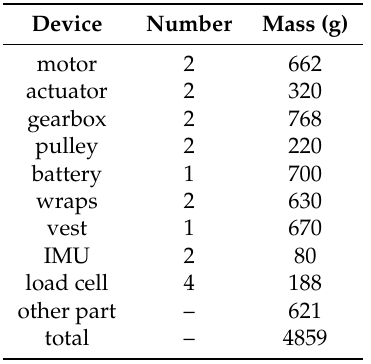
Table 1. The weight of each part of our soft